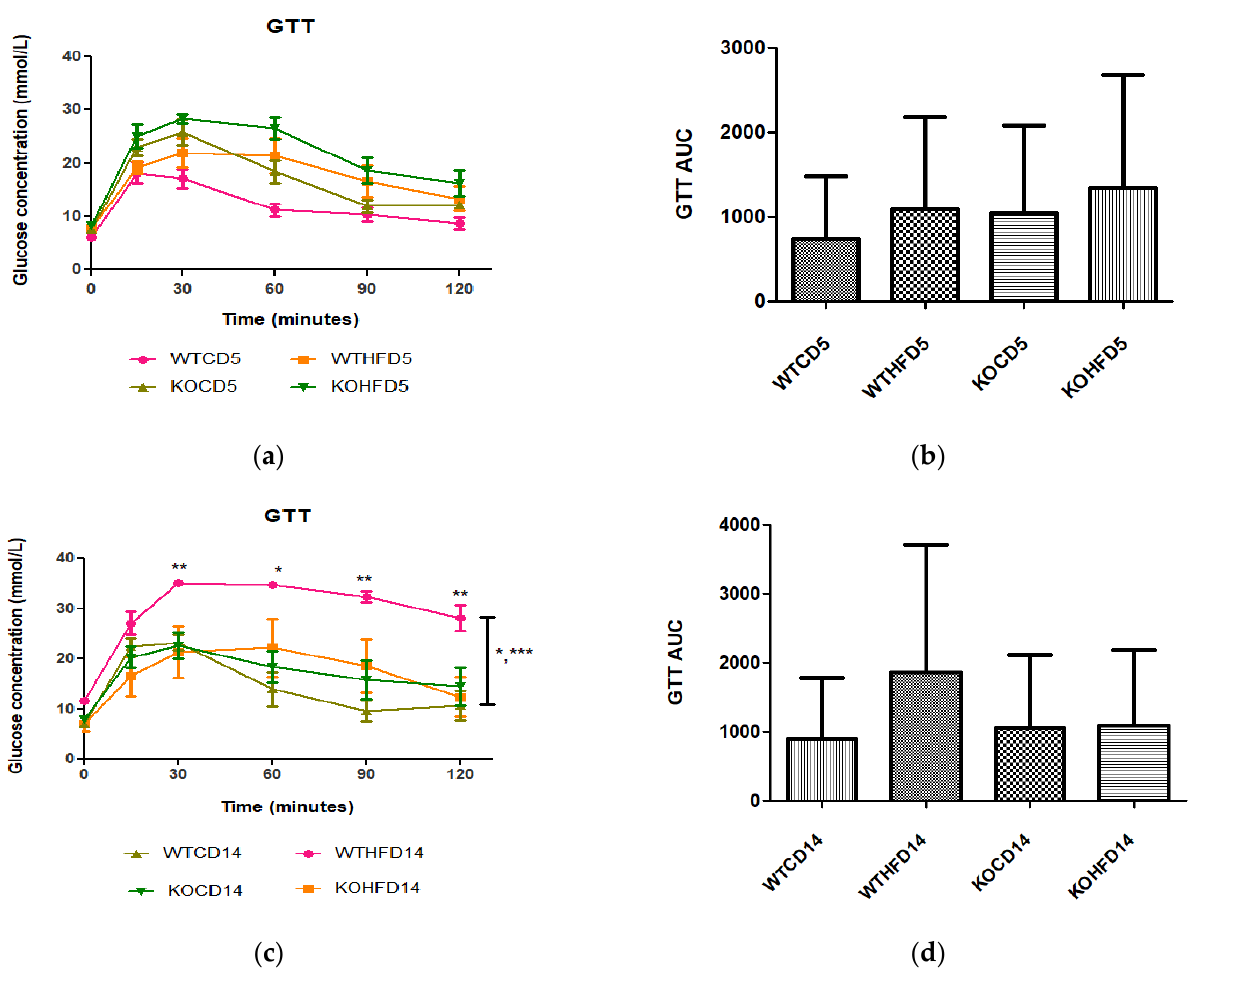
Figure 3. Glucose tolerance and insulin sensitivity tests of animals on experimental diet. ( a ) No significant differences were observed after experimental feeding between WT and KO mice on either CD or HFD at 5 weeks. ( c ) WTHFD showed significantly higher glucose levels than KOHFD ( p < 0.05, 0.01) and WTCD ( p < 0.05, 0.001) at 14 weeks. ( b , d ) No significant differences were observed between WTCD5, WTHFD5, KOCD5, and KOHFD5 and their respective 14-week counterparts. N = 6 for WTCD5, WTHFD5, KOCD5, KOHFD5, WTCD14 WTHFD14, and KOCD14 and N = 5 for KOHFD14. * p < 0.05, ** p < 0.01, *** p < 0.001.